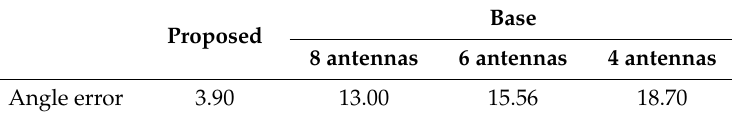
Figure 9. CDF (cumulative distribution function) of angle error. Table 2. Average of angle error (degree).